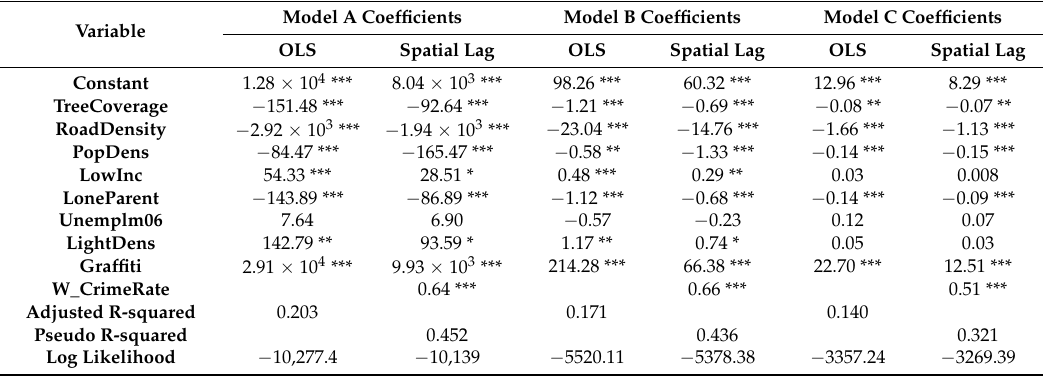
Table 2. Coefficients and significance levels of Ordinary Least-Squares (OLS) and Spatial Lag regression models (Model A: property crime, Model B: theft, Model C: